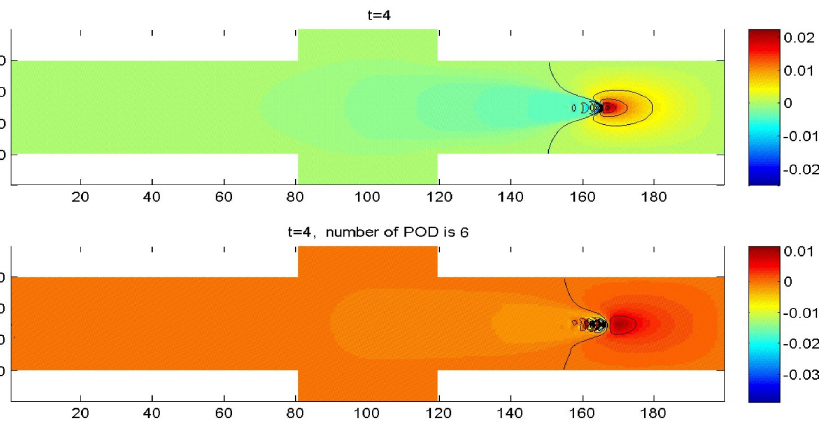
Figure 7. Top chart is the classical SCNMFE solution of pressure p and bottom chart is the POD-based reduced-order SCNMFE solution of pressure p with 6 POD bases when Re = 1000 and Pr = 7 at time t =